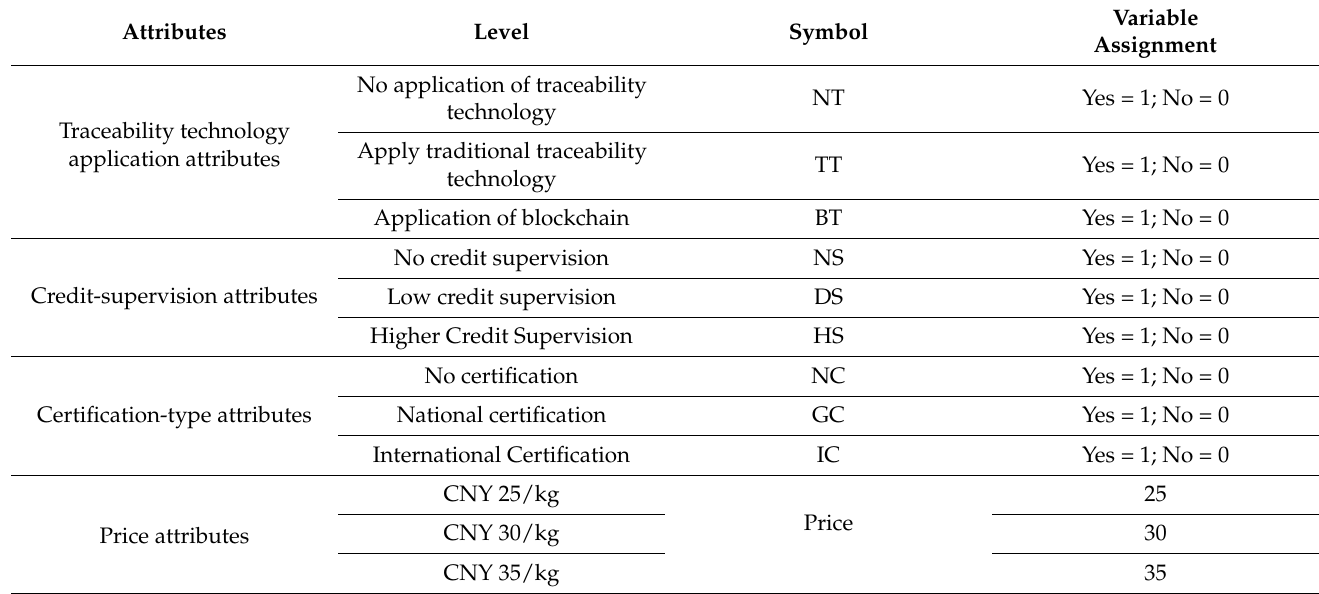
Table 1. Traceable organic rice attributes and their level